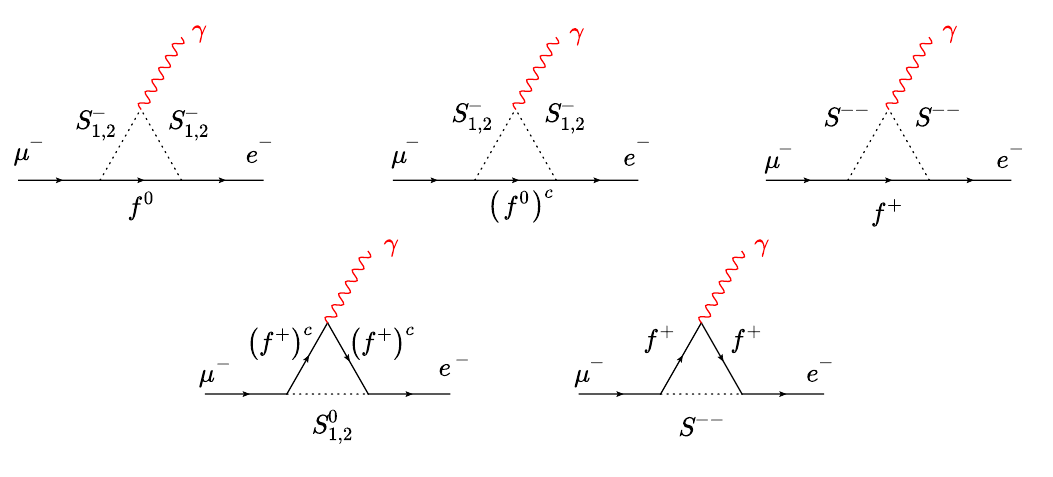
Figure 3 . Diagrams contributing to µ → eγ . In total, there are 8 diagram with non-zero contri- bution to the